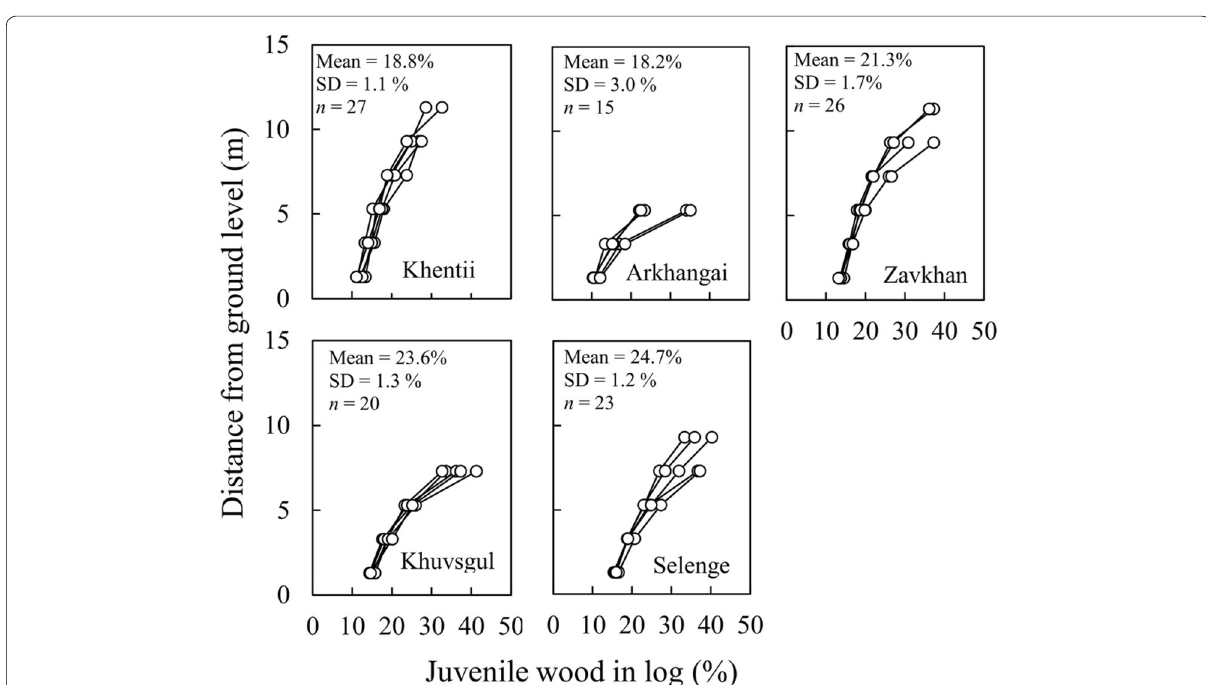
Fig. 3 Longitudinal variations of juvenile wood percentage of logs in each provenance. Open circles indicate juvenile wood percentage of log from individual tree. SD standard deviation; n number of lumber